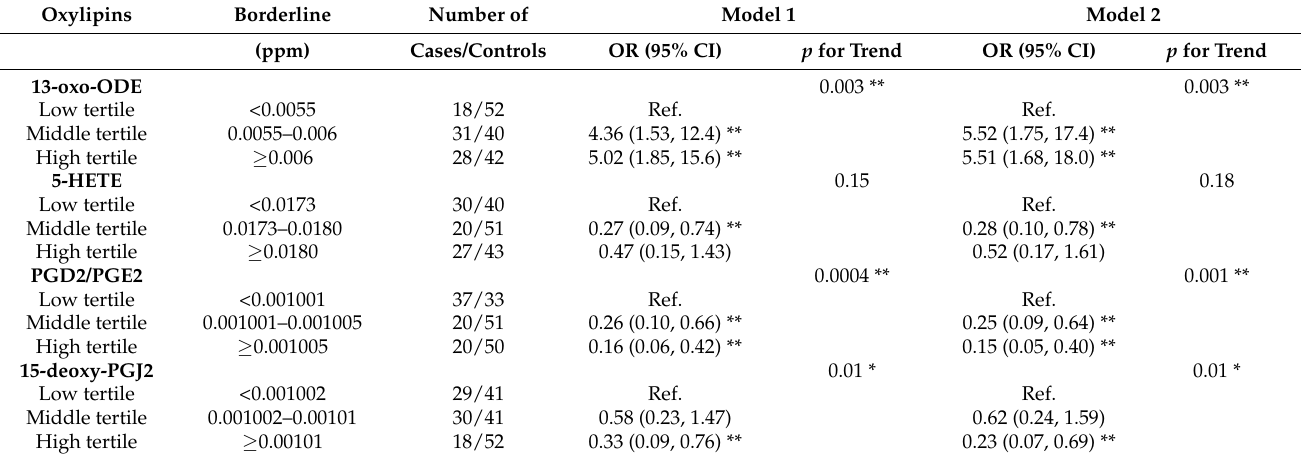
Model 1: Adjusted for hypertension, diabetes mellitus, hypertriglyceridemia, hypercholesterolemia, drinking, smoking, experimental batch effects, and these oxylipins. Model 2: Adjusted for above variables and